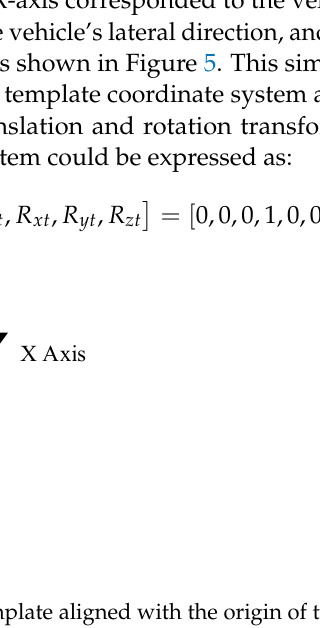
Figure 5. Target vehicle point cloud template aligned with the origin of the global coordinate sys- tem, which was elaborated on in detail in Section 4.1.1.